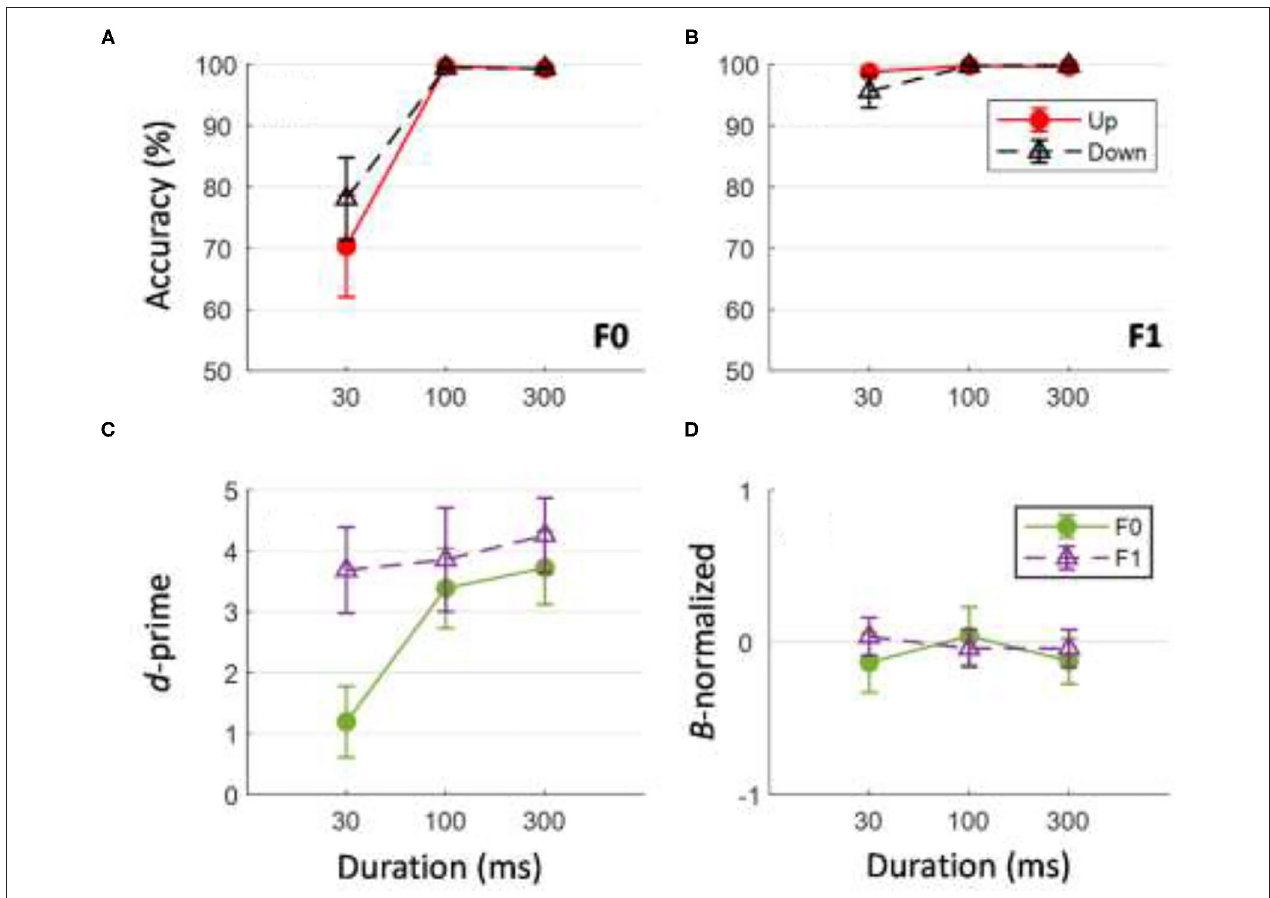
FIGURE 10 | Behavioral accuracy and ß -normalized values in direction identification of tone sweeps for F0 (A) and F1 (B) frequency formants across all three durations. Bottom panel shows corresponding d -prime (C) and ß -normalized values (D) for behavioral performance. In (D) , value near 0 indicates no response bias in behavioral task. Error bars indicates ± 1 standard